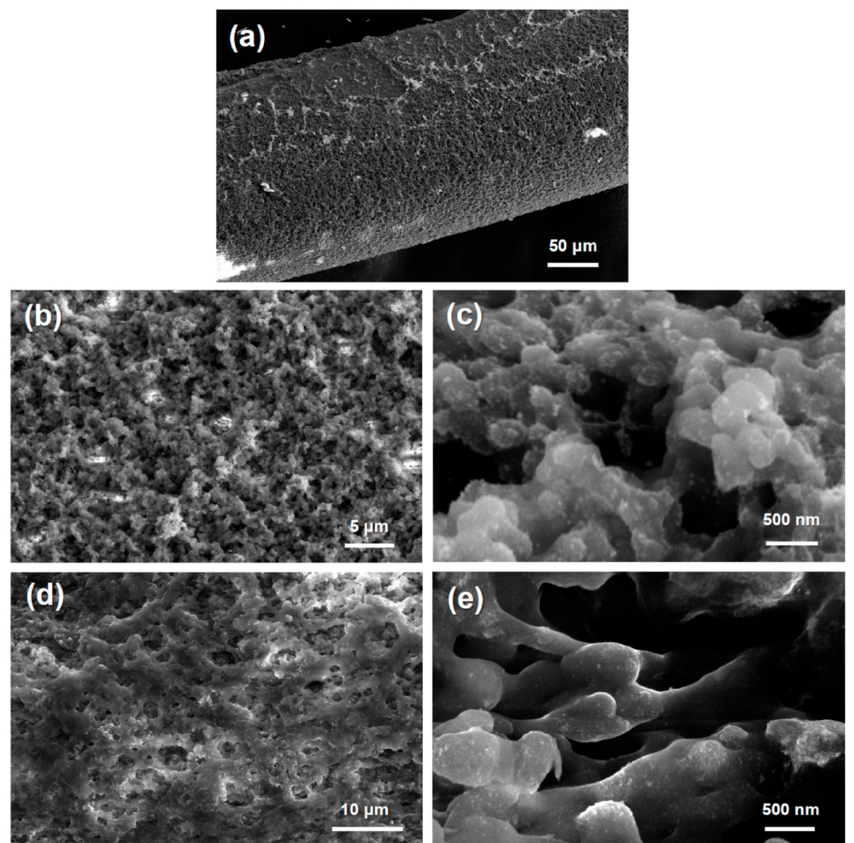
Figure 2. Scanning electron microscopy images. ( a – c ) The silk–palladium composite aerogel fibers. ( d – e ) The silk–platinum composite aerogel fibers.